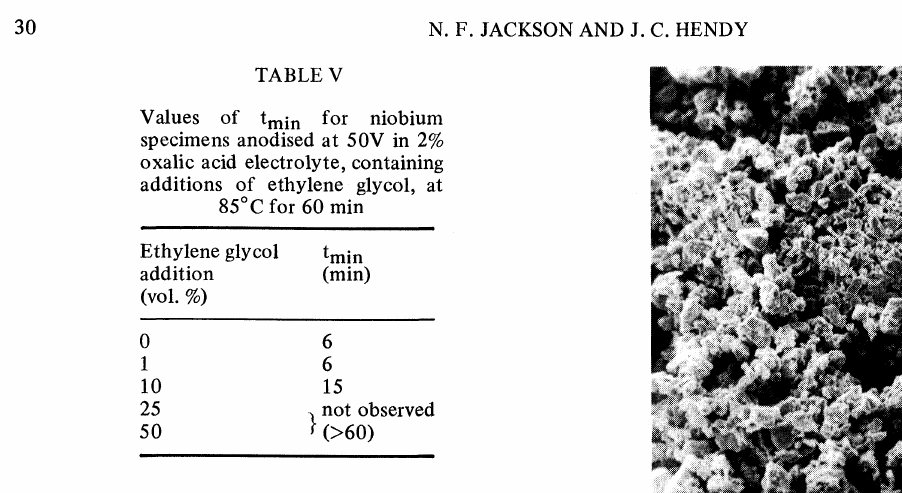
Values of tmi n for niobium specimens anodised at 50V in 2% oxalic acid electrolyte, containing additions of ethylene glycol, at